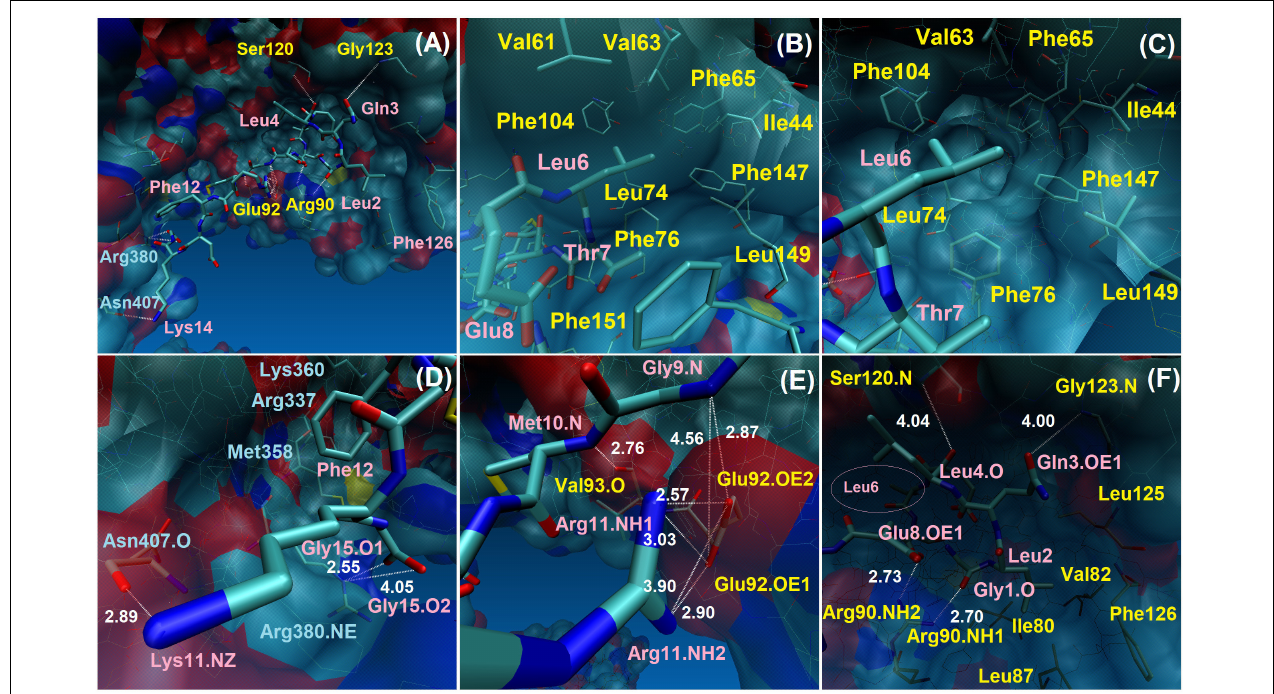
FIGURE 6 | Interactions between TLR4/MD2 monomeric complex and Peptide-2 observed by MD simulations at 310 K for 100 ns. (A) Full perspective of Peptide-2 binding mode with TLR4/MD2 complex, only a few residues are included for positional reference, details and close-ups are shown below. (B,C) Different perspectives of the MD2 hydrophobic pocket and its residues around Leu6 and contiguous residues of Peptide-2. (D) Interactions of TLR4 with Peptide-2 residues. (E,F) Interactions of MD2 with Peptide-2 residues (Leu6 lies deep within the MD2 binding site, left side of panel (F) , smaller label at pink circle). Blue labels: TLR4 residues. Pink labels: Peptide-2 residues. Yellow labels: MD2 residues. Only H-bond distances were measured (in angstroms or Å, white labels, white dotted lines). Single O or N: backbone residue atoms. NH1, NH2: nitrogen atoms at the end of the arginine side chain. NE: nitrogen epsilon atom of arginine side chain. NZ: nitrogen atom of lysine side chain. O1, O2: glycine 1 oxygen atoms at the C-terminus of Peptide-2. OE1, OE2: oxygen atoms of glutamic acid side chain. All images were taken at 60 ns, at which point most interactions are noticeable. More details in Supplementary Table 2 .